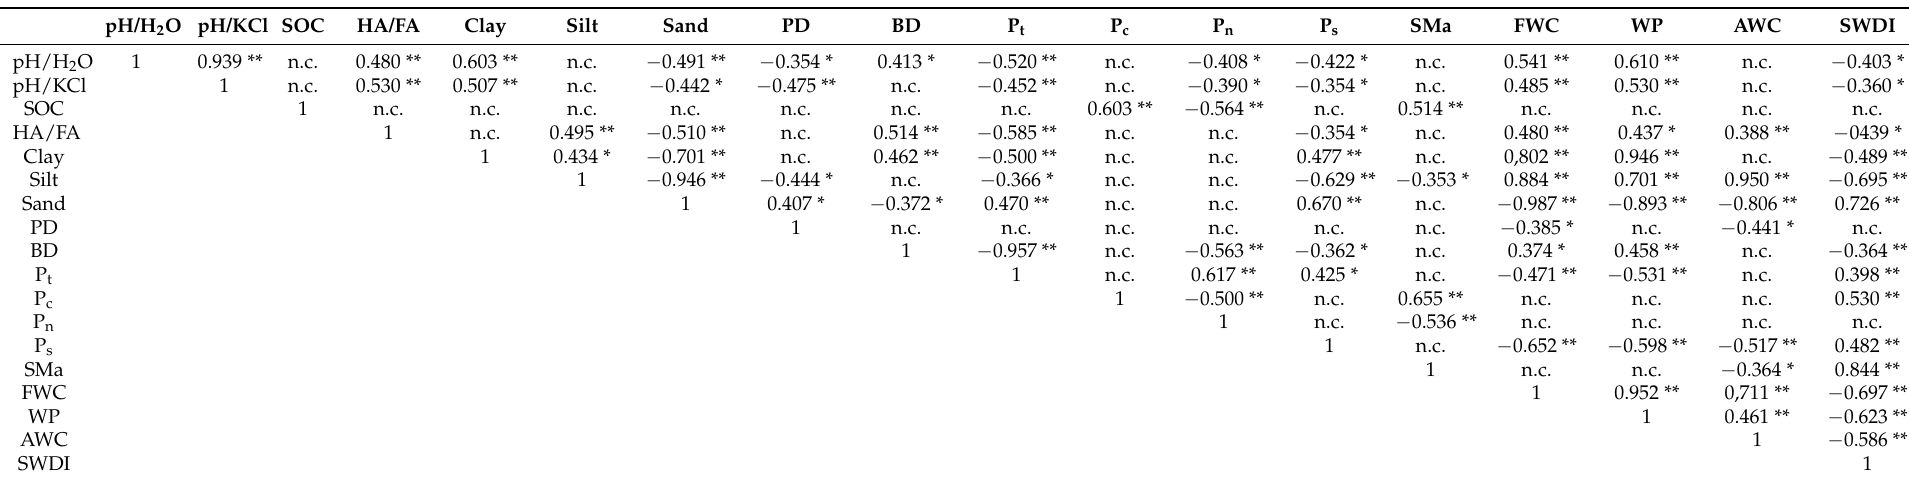
Table 4. Pearson ´ s correlation coefficient matrix of soil